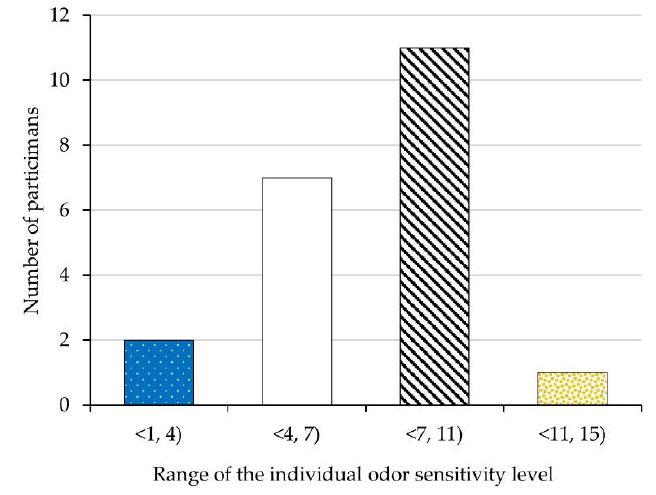
Figure 4. Individual odor sensitivity levels of the study participants.